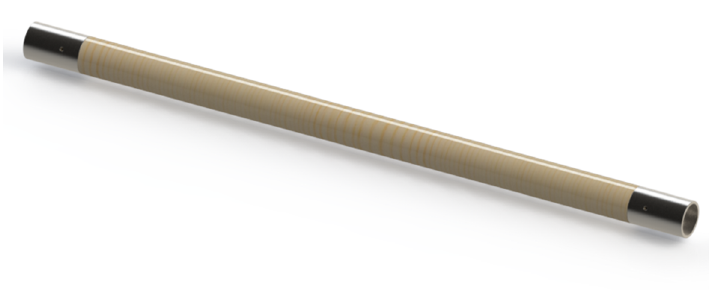
Figure 17. Tension roller.